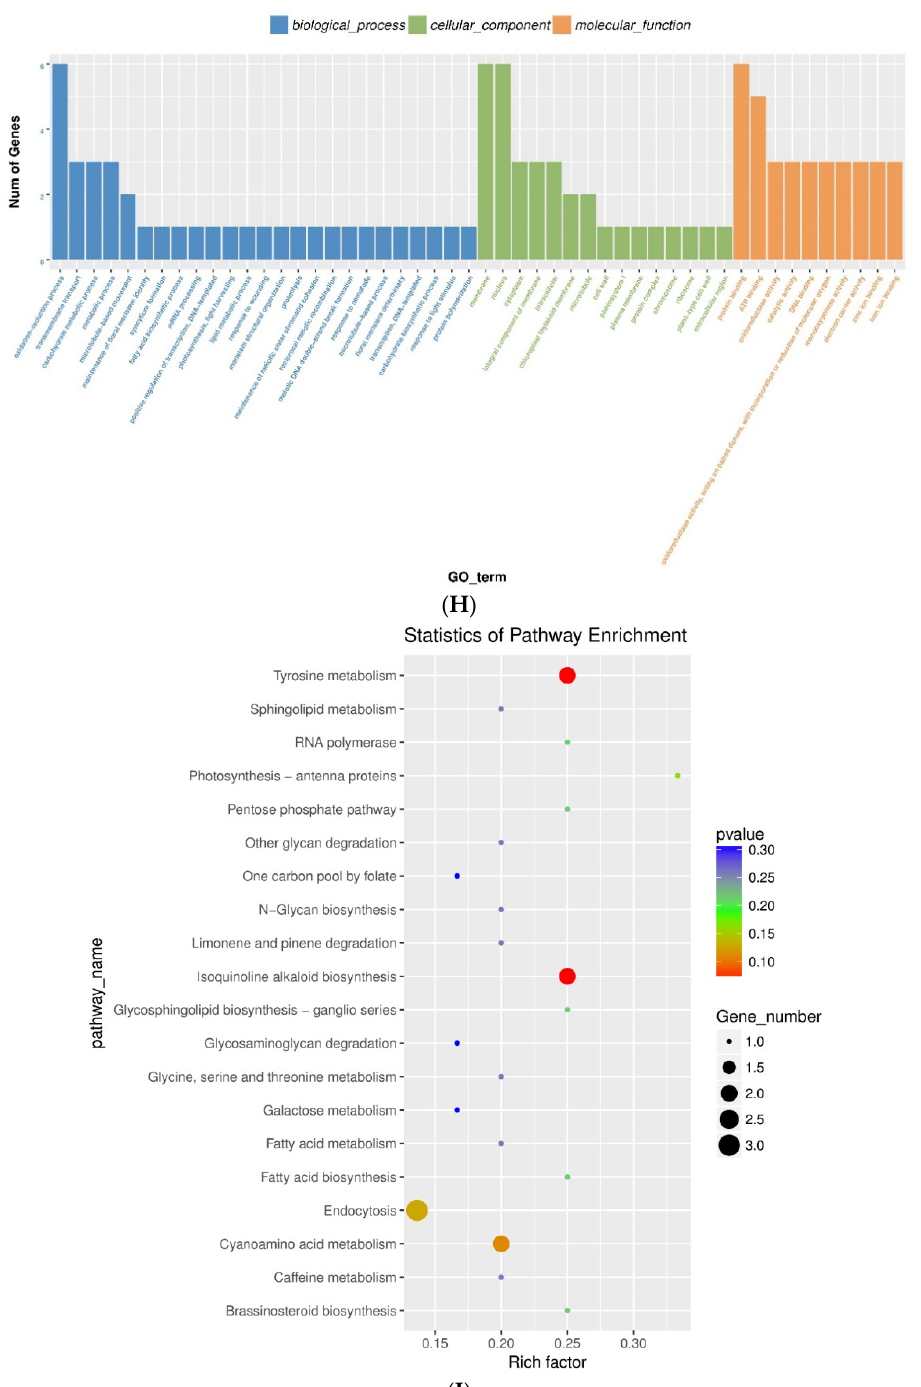
Figure 2. Identification and analysis of long-coding RNAs (lncRNAs) under vernalization. ( A ) The number of upregulated and downregulated differentially expressed lncRNAs identified between the vernalized and nonvernalized samples; ( B ) The number of significant differentially expressed lncRNAs between the vernalized and nonvernalized samples; ( C ) The volcano plot of differentially expressed lncRNAs; ( D ) Transcript length distribution of differentially expressed lncRNAs and mRNAs; ( E , F ) ORF length distribution of differentially expressed lncRNAs and mRNAs; ( G ) The exon number of differentially expressed lncRNAs and mRNAs; ( H ) Gene Ontology (GO) classifications; and ( I ) Kyoto Encyclopedia of Genes and Genome (KEGG) pathway assignments for all differentially expressed